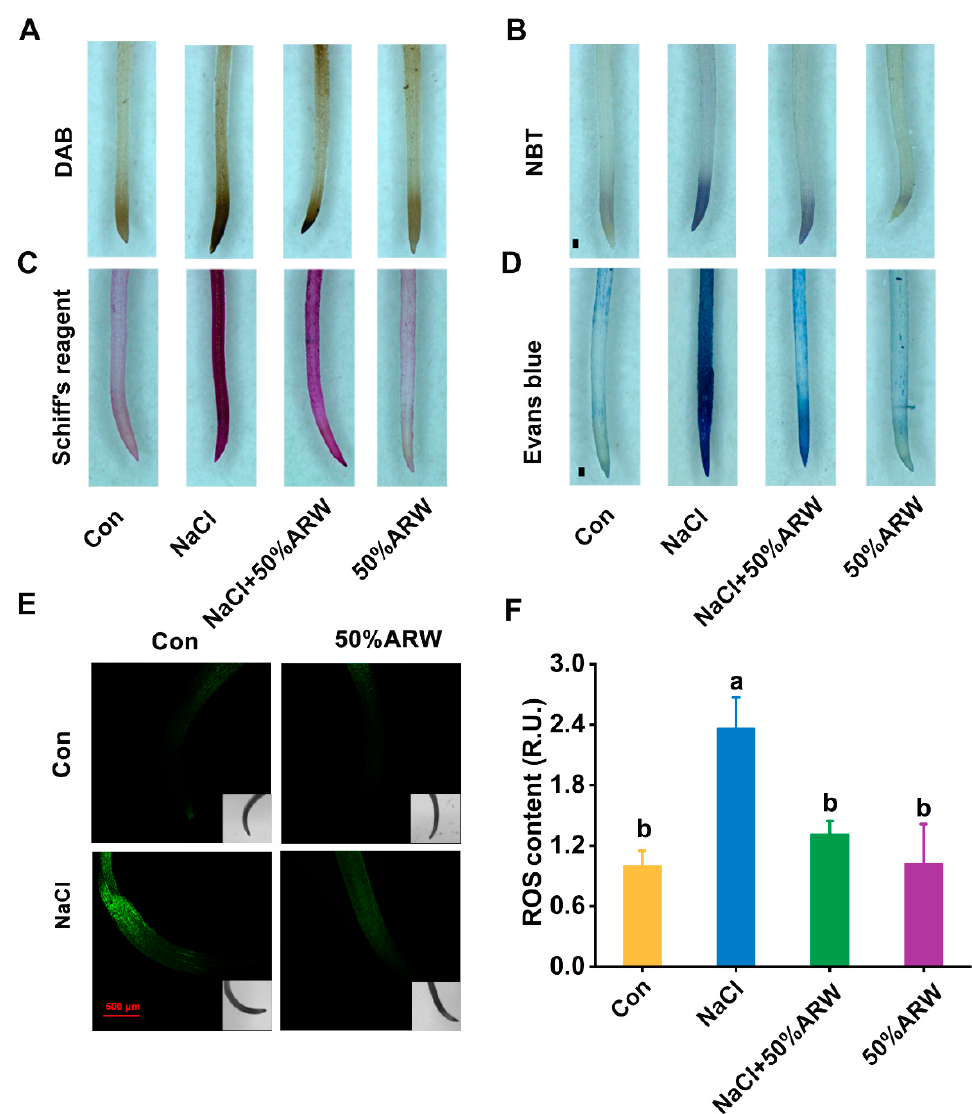
Figure 4. Redox homeostasis was reestablished by argon. After germination for 3 d, root tissues were stained with DAB ( A ) and NBT ( B ) to visualize the distribution of H 2 O 2 or O 2 − , respectively. The roots were stained with Schiff’s reagent ( C ) and Evans blue ( D ) to determine lipid peroxidation and plasma membrane integrity, respectively. Bars = 0.5 mm. DCF-dependent fluorescence ( E ) was also imaged, and relative intensities ( F ) are given. R.U., relative unit. Bar = 500 µ m. The error bars represent the SD ( n = 3; 50 samples/treatment/repeat). Bars with different letters (a,b) were significantly different at p < 0.05 according to Duncan’s multiple range test.